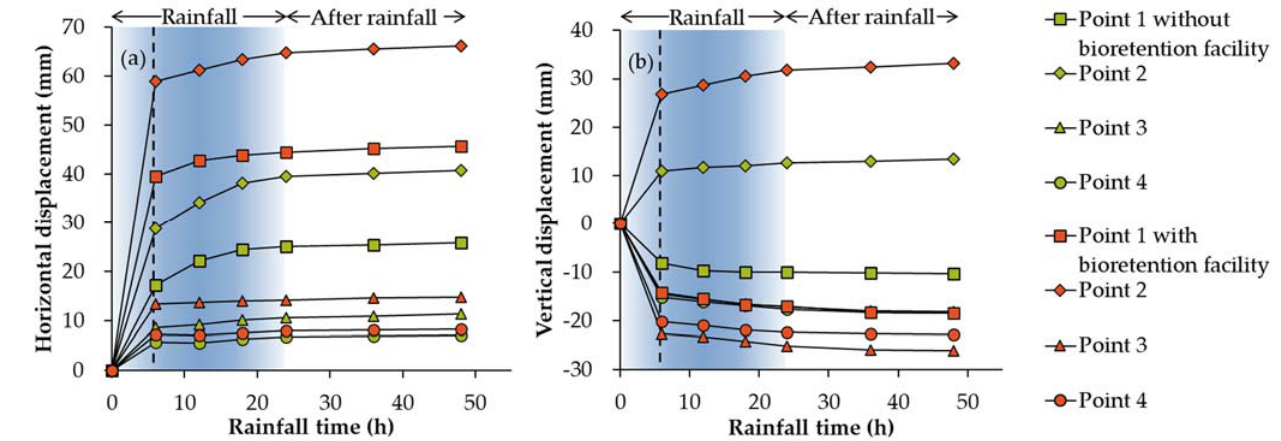
Figure 11. Horizontal ( a ) and vertical ( b ) displacement curves of different control points. At the same time, vertical downward displacement of 10.1 mm, 17.2 mm, and 17.7 mm at control point 1, control point 3, and control point 4 were observed. The vertical displacement of control point 3 and control point 4 is greater than that of control point 1.